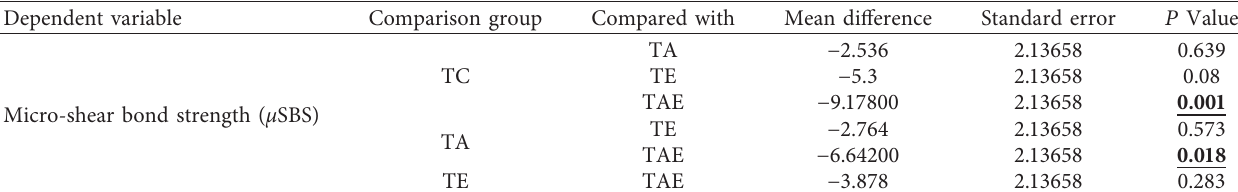
Table 7: Post hoc Tukey test for the translucent groups showing significant